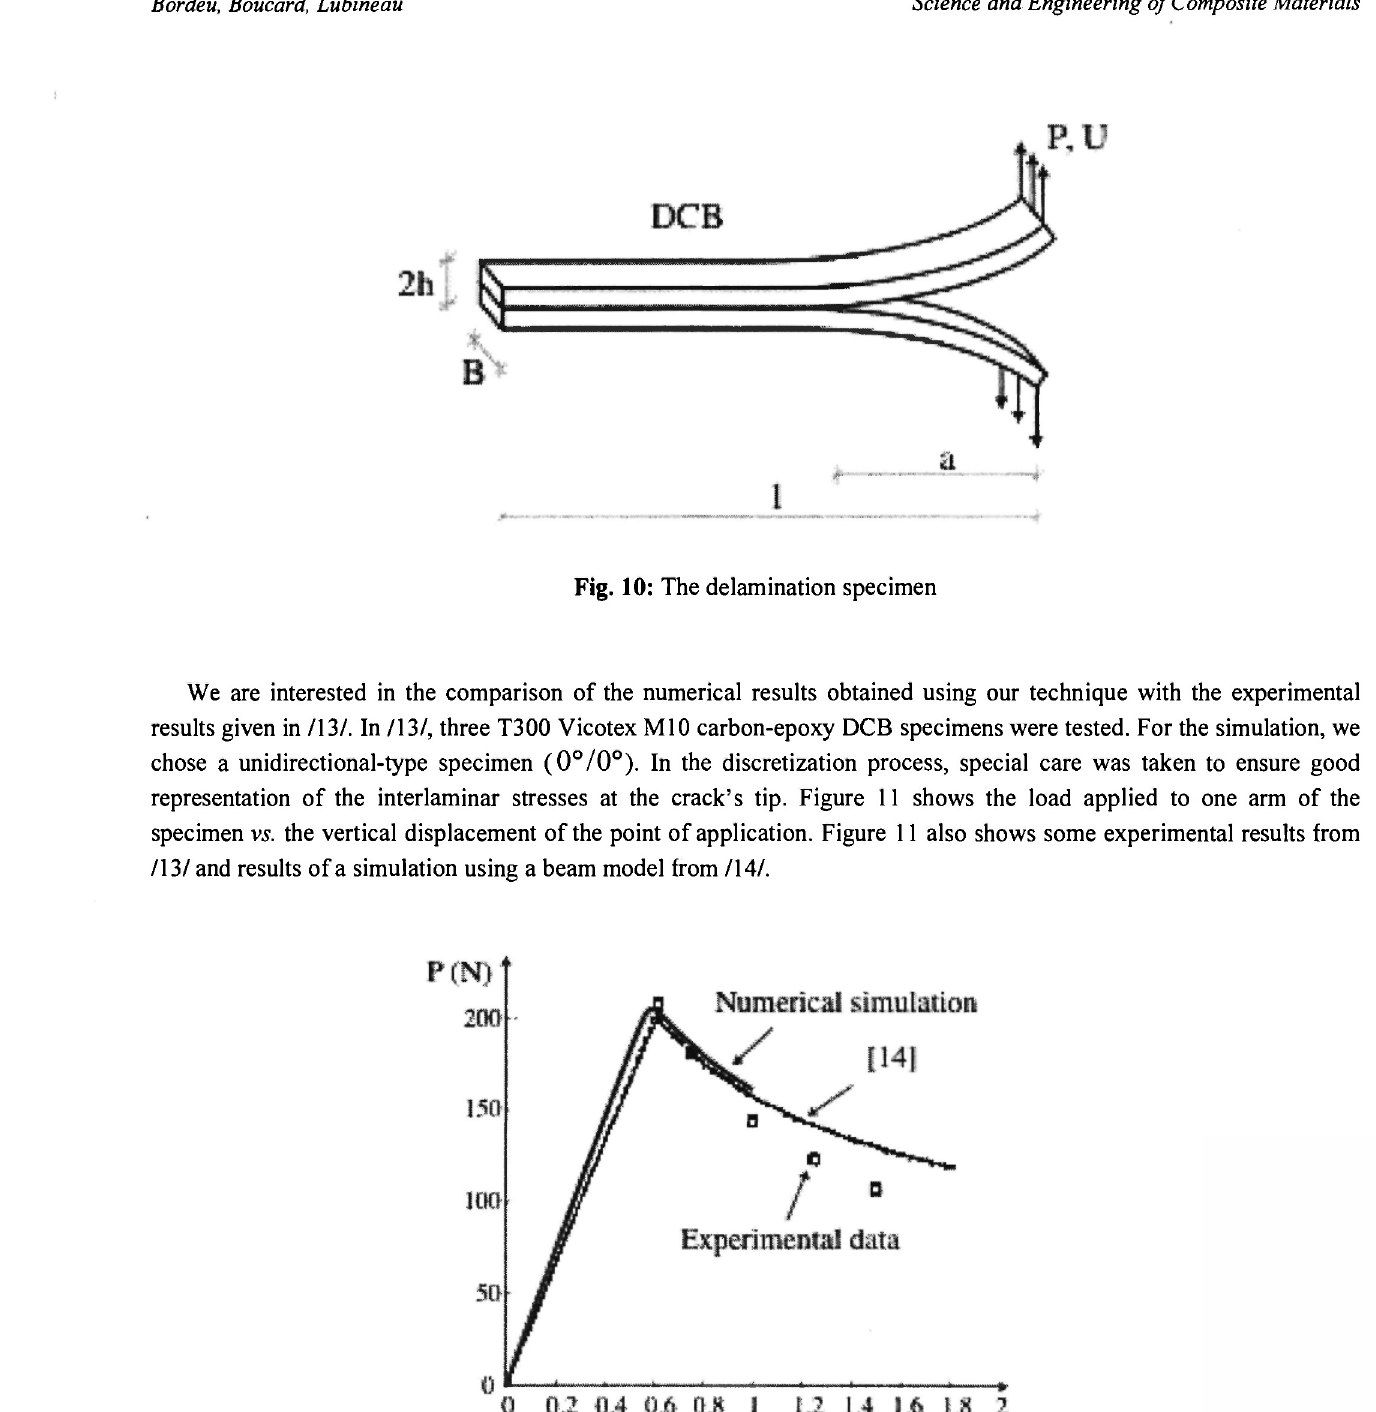
Fig. 11 : Comparison between experiment and simulation (force vs.